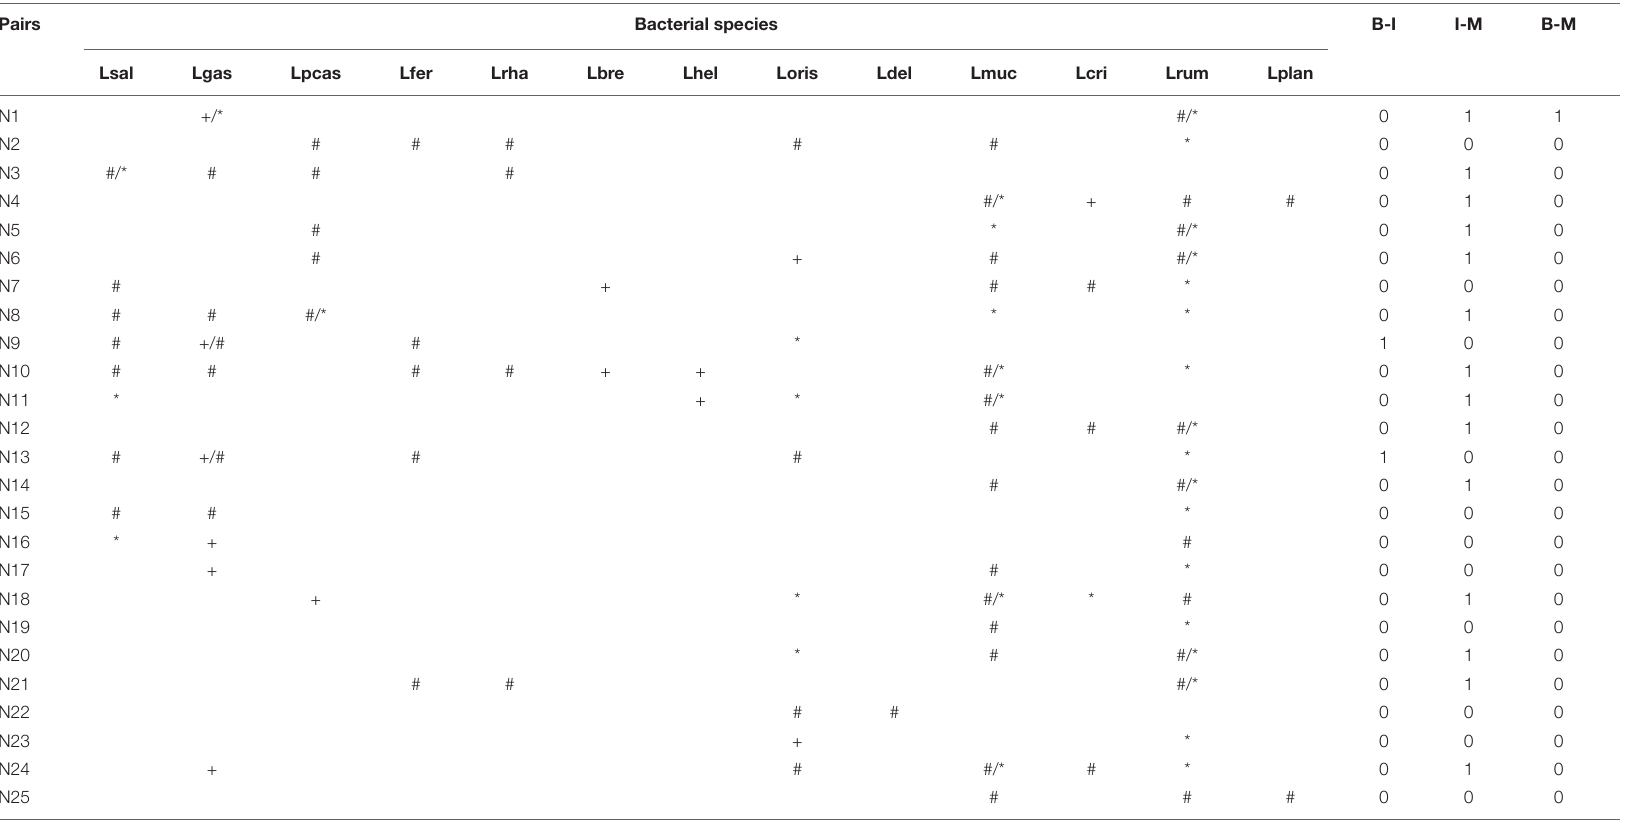
TABLE 4 | Lactobacillus species shared by mother–infant pairs. Pairs Bacterial